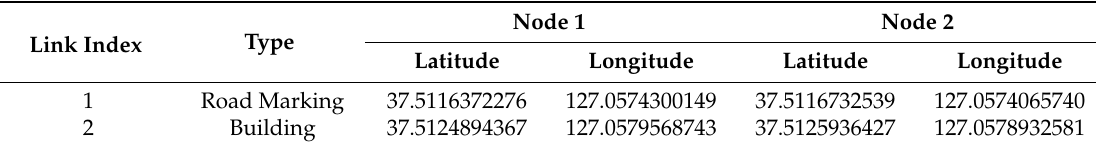
Table 1. Example of ELM.